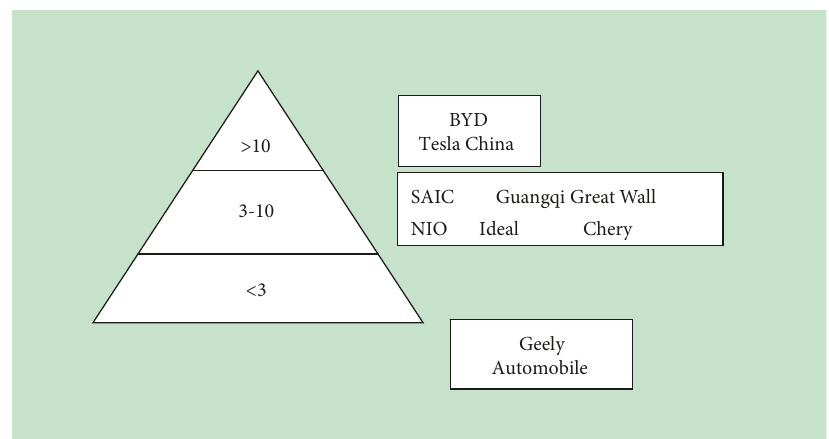
Figure 3: Competitive Echelon of China’s new energy vehicle industry (sales) (unit: 10,000 vehicles).